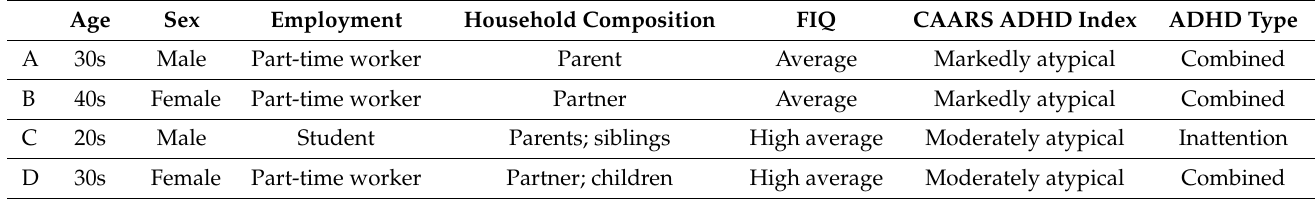
Table 1. The demographic and clinical data of the